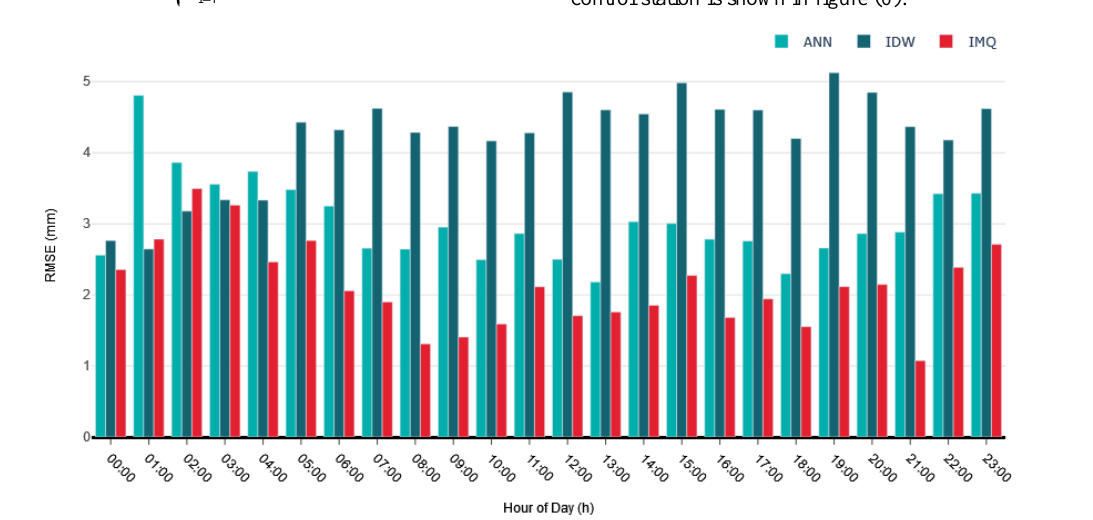
Figure 5. RMSE of different interpolation schemes (in hour